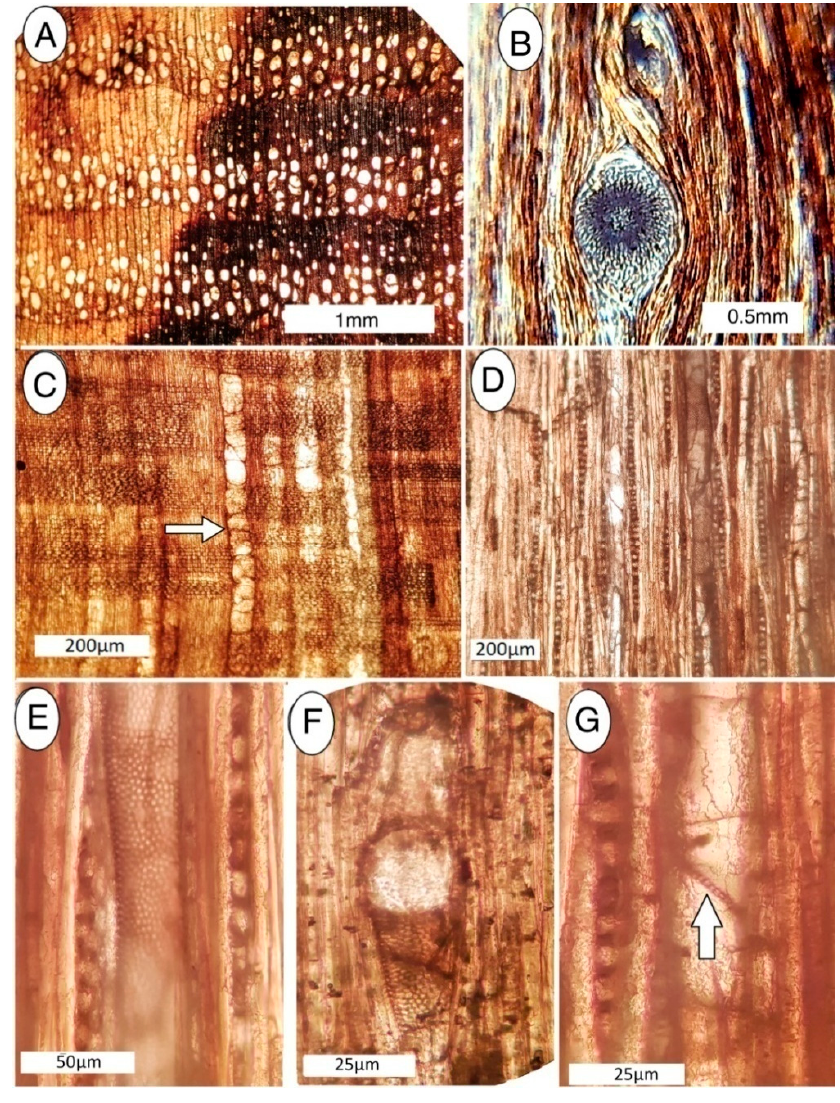
Figure 9. Anatomical features of angiosperm wood, trunk T-10. ( A ) Ring porous structure as seen in transverse view. ( B ) Transverse view showing branch attachment. ( C ) Radial view. Vessels segmented by tyloses can be seen in profile view (arrow), with horizontal rays. (D ) Tangential view showing rays in cross section. ( E ) Tangential view of epithelial cells (parenchyma cells) surrounding a pit. ( F ) Paranchyma cells adjacent to vessel. ( G ) Tangential view of vessel showing scalariform perforation plate (arrow).